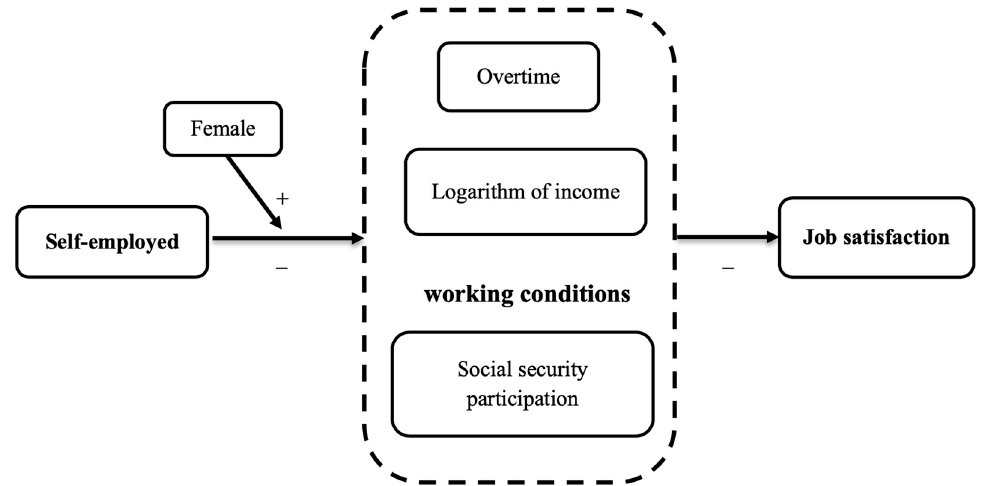
Figure 3. The impact of self-employment on job satisfaction and its